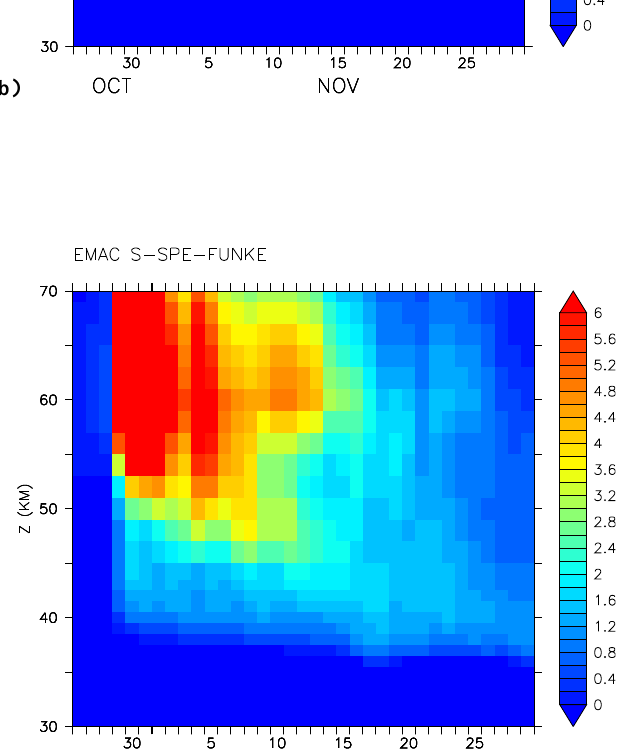
Fig. 7. Mixing ratios of N 2 O at 60 km, 75 ◦ N from the CAABA box model at three different temperatures (lines), and MIPAS N 2 O measurements for the same latitude region.